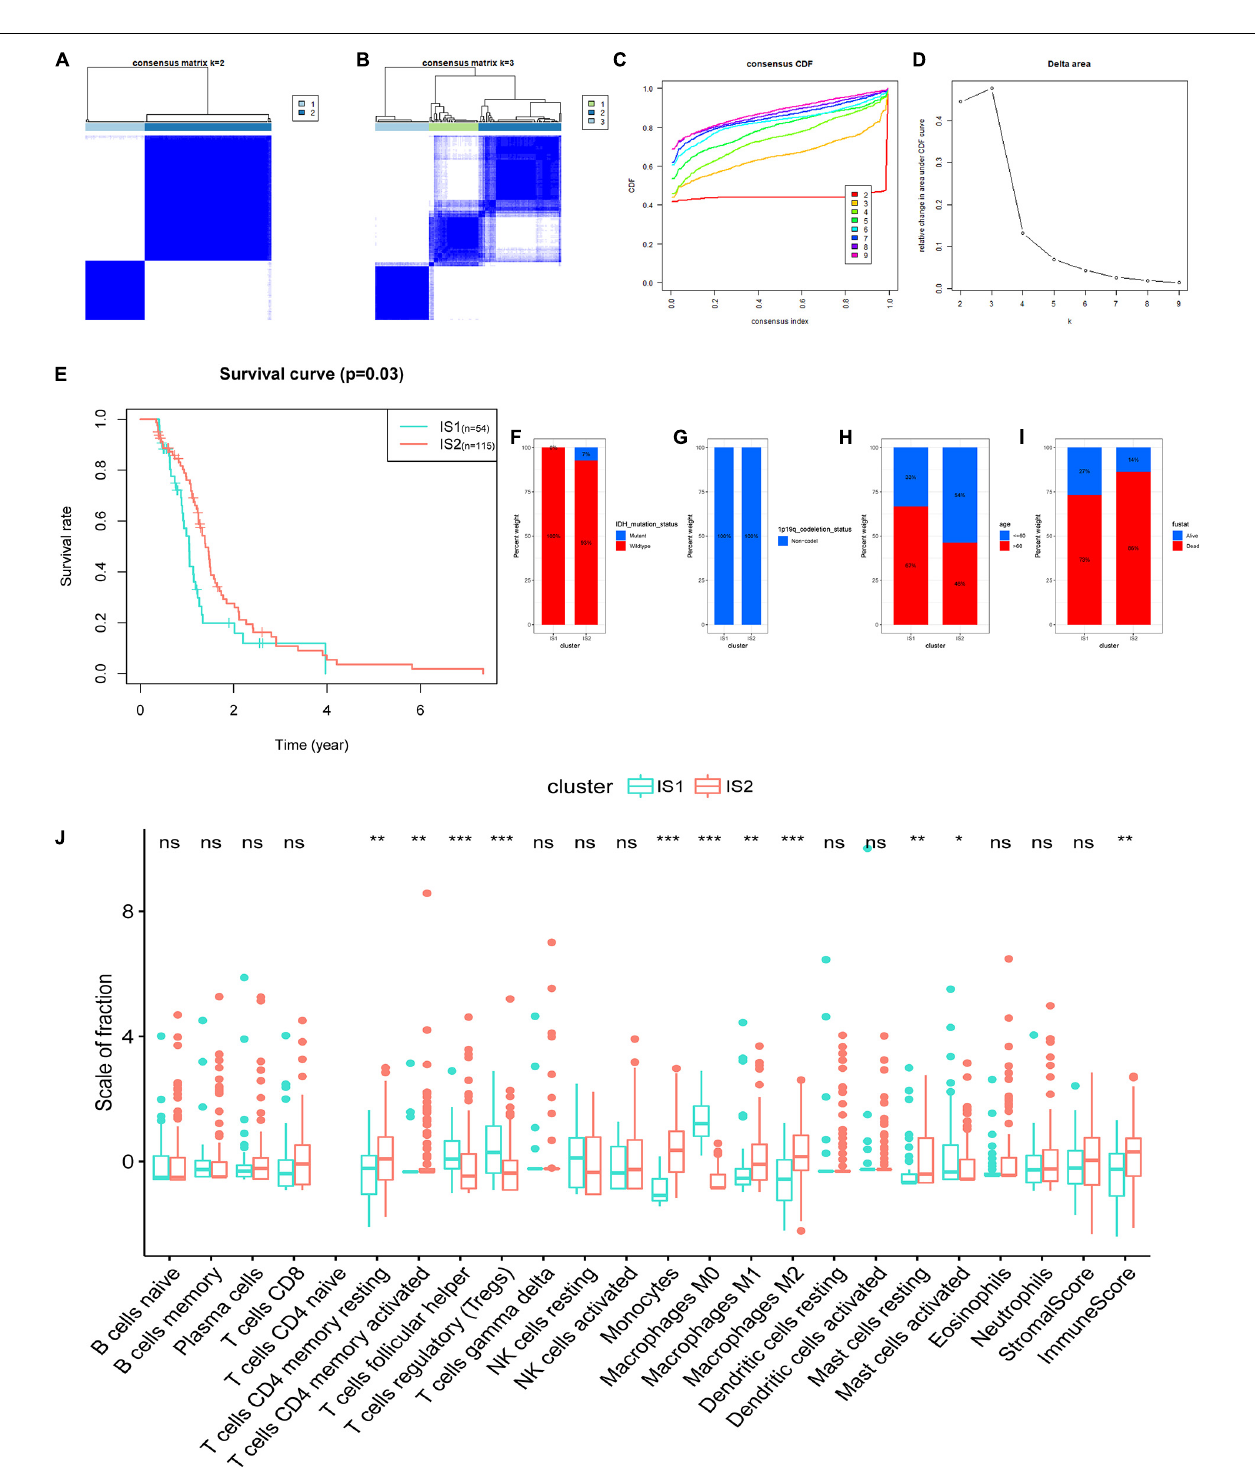
FIGURE 5 | Identification of immune subtypes of GBM based on the consensus clustering of the abundance of 22 kinds of tumor immune infiltrating cells (TIICs). (A) Consensus clustering matrix of 169 The Cancer Genome Atlas (TCGA)-GBM samples for k = 2 and (B) k = 3. (C) Consensus clustering CDF for k = 2 to k = 9. (D) Relative change in area under CDF curve for k = 2 to k = 9. (E) Survival analysis between the OS and two subtypes. Distribution ratio of (F) IDH mutation status, (G) 1p19q co-deletion status, (H) age group (cut off: 60 years old), and (I) survival status among immune subtype 1 (IS1)-immune subtype 2 (IS2) in TCGA-GBM. (J) The difference analysis of the abundance of immune cells and the stromal and immune scores in IS1 and IS2. Fustat: survival status. *** p < 0.001, ** p < 0.01, * p < 0.05, ns: not significant.